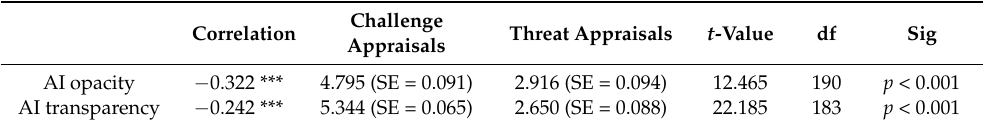
Table 5. Results of the paired sample t